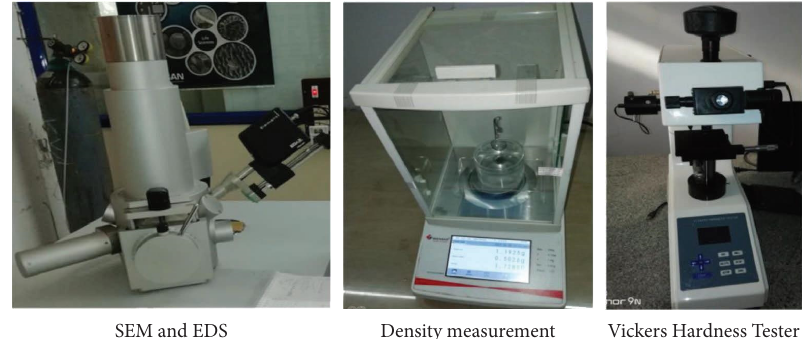
Figure 2: Photographs of SEM with EDS, density, and hardness